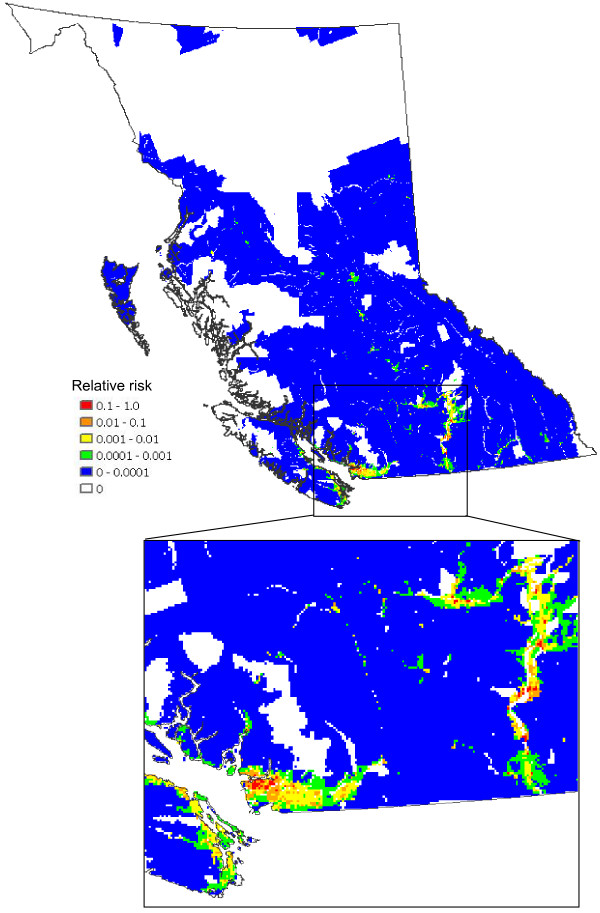
Risk of human infection. All of BC (upper) and a more detailed look at the high risk areas (lower) (Normalized product of Figure 8 and human population (≥ 60 years old) density divided by the maximum value)